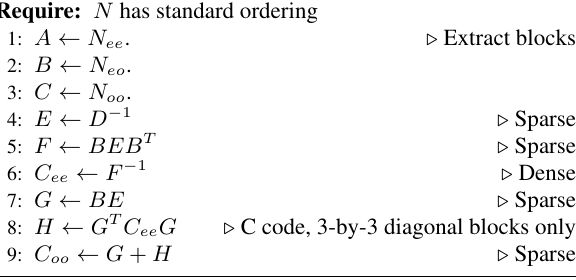
Figure 3: A self-calibration normal matrix has an added border of dense blocks. The blocks have a thickness equal to the num- ber of estimated IO parameters. In the standard ordering (left), the IO blocks form the left and upper border of the matrix. In the arrowhead ordering, the IO blocks instead form the lower and right border. Algorithm 1 The classic algorithm for computing posterior co- variance for object points. The sparse and dense steps are com- puted in Matlab using sparse and dense linear algebra routines, respectively. The C code step is computed by compiled C-code called from Matlab (”mex” code).